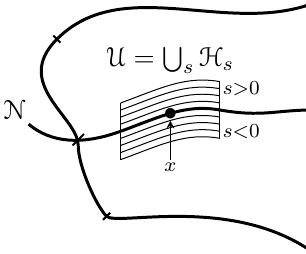
Figure 4 . Singular locus in a cyclic universe. In this example, the singular locus N consists of two singularity hypersurfaces, one of which is spacelike. The codimension 2 locus P (depicted by three ticks along N ) consists of their intersection and of the two-dimensional locus where a hypersurface changes between timelike and spacelike nature. It could have additional components near which the approximation of the metric by an asymptotic profile breaks down (so-called spikes). By definition, every x ∈ N \ P admits a neighborhood U with a (spacelike or timelike) Gaussian foliation such that H N ∩ U 0 =